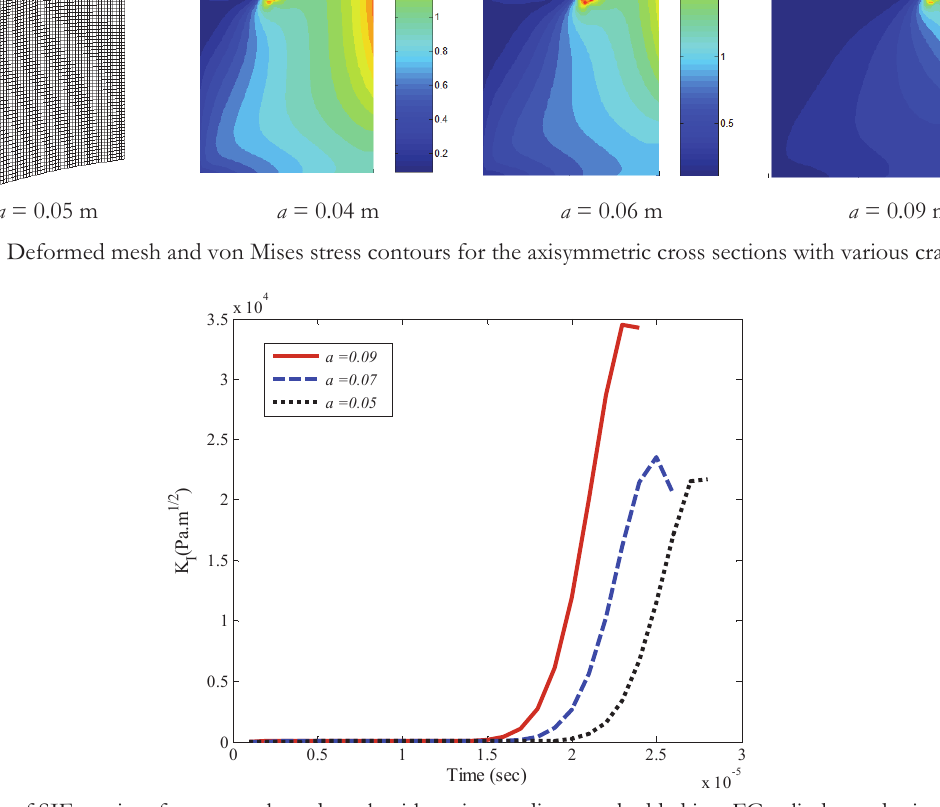
Figure 6: Plots of SIF vs. time for penny-shaped crack with various radiuses embedded in a FG cylinder under impulsive tension.